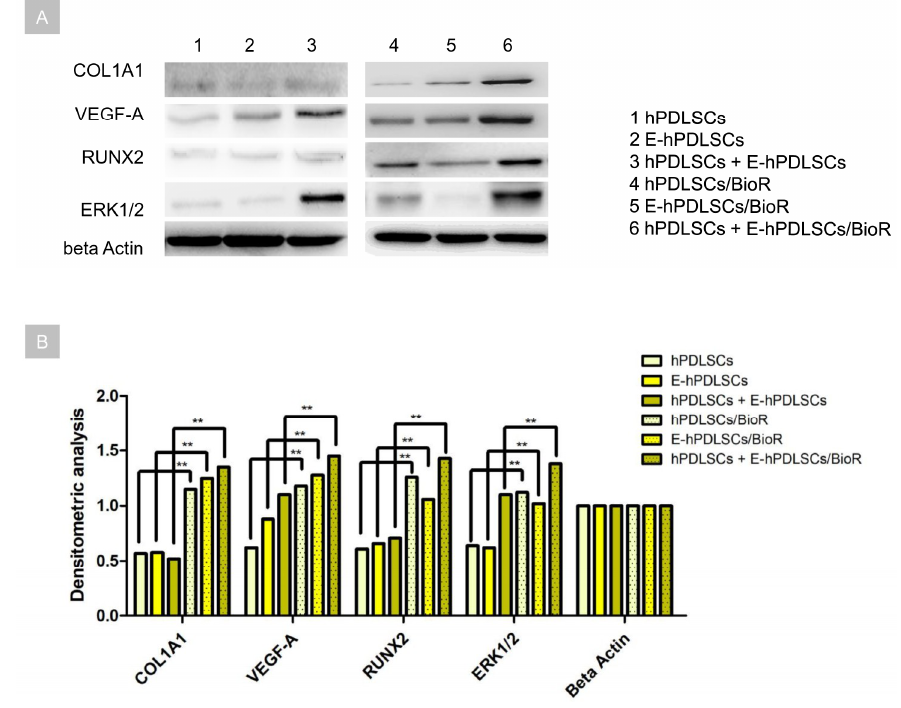
Figure 7. Western blot. ( A ) Protein levels specific band. Beta actin has been used as housekeeping protein. ( B ) Graph showed the specific band densitometric levels. ** p < 0.01.